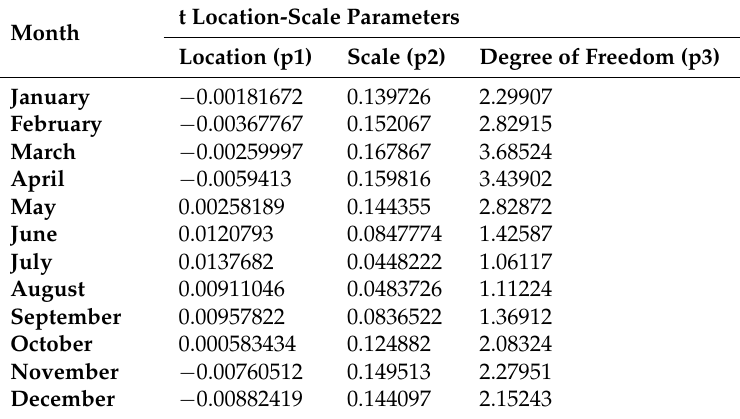
Table 3. Parameters of the t location-scale distribution resulting from the analysis of E 1˚ m